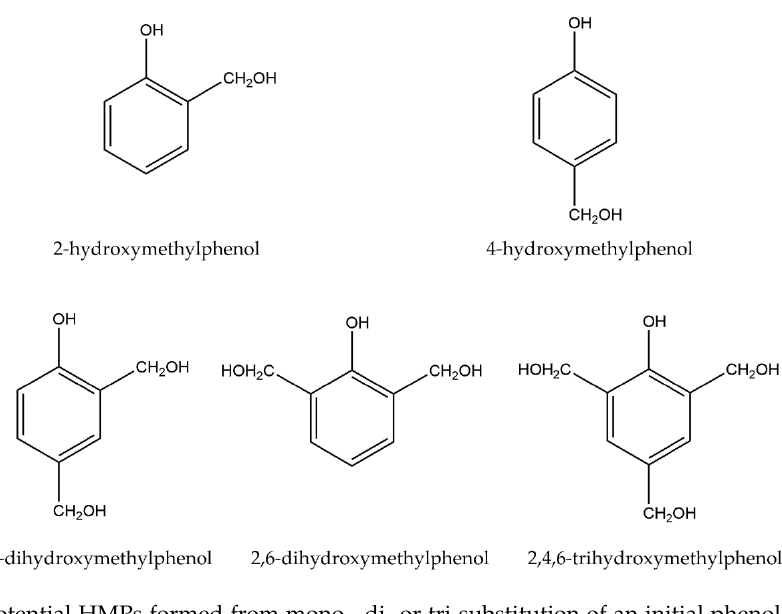
Figure 1. Potential HMPs formed from mono-, di- or tri-substitution of an initial phenol molecule with formaldehyde.